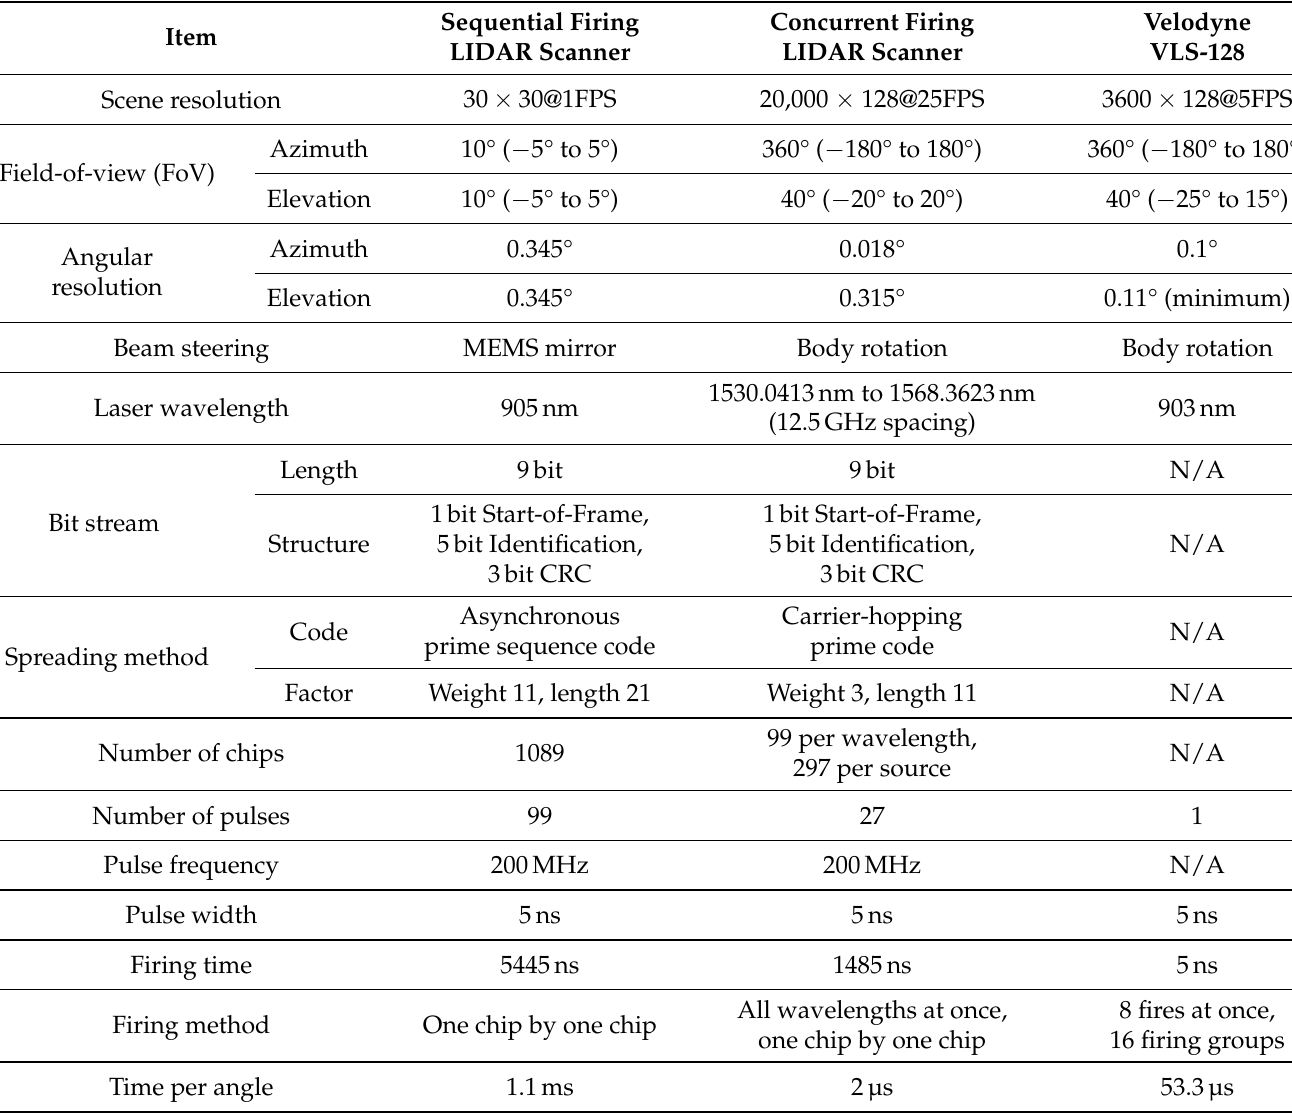
Table 3. Specification comparison with other LiDAR